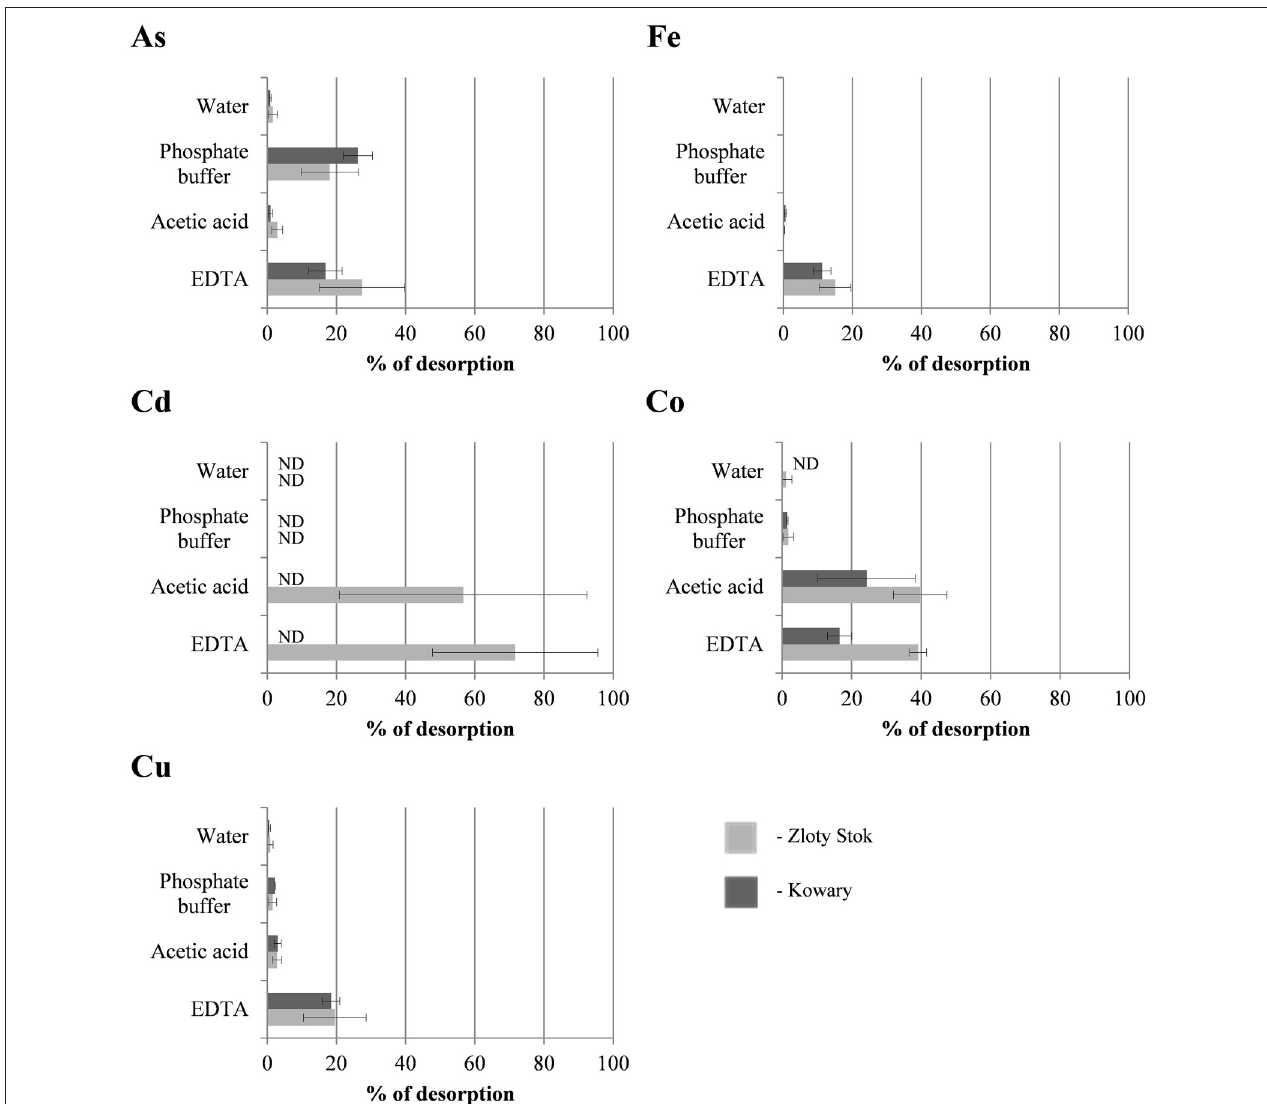
FIGURE 3 | Extraction efficiency of As, Cd, Co, Cu, and Fe accumulated in microbial mats from KOW and ZS. Four different eluents were used: deionized water, 0.1 M phosphate buffer, pH = 7.2, 0.11 M acetic acid pH = 3.5, and 0.05 M EDTA pH = 7. Each bar shows the average amount of metal ion extracted from the mat (3 repeats, SD showed on graph). ND, metal not detected in the extracted